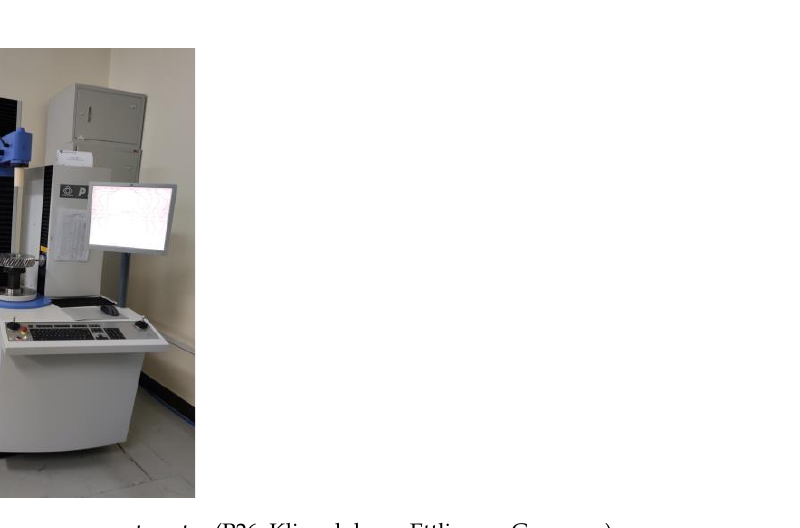
10 of 13 Figure 9. 3D normal deviations of the right tooth surface of the first tooth: ( a ) 3D topological error; ( b ) error contour map. On the basis of the 2D tooth surface, the error basement criteria specified in ISO 1328 and the 3D tooth surface normal deviations, the deviation in different directions can be extracted and evaluated as per the requirement. The profile and helix deviations are ex- tracted in the gear radial and gear width directions, respectively (Figure 10). Figure 10. Extraction of the profile and helix deviations: ( a ) 3D topological error, ( b ) profile devia- tions, and ( c ) helix deviations.